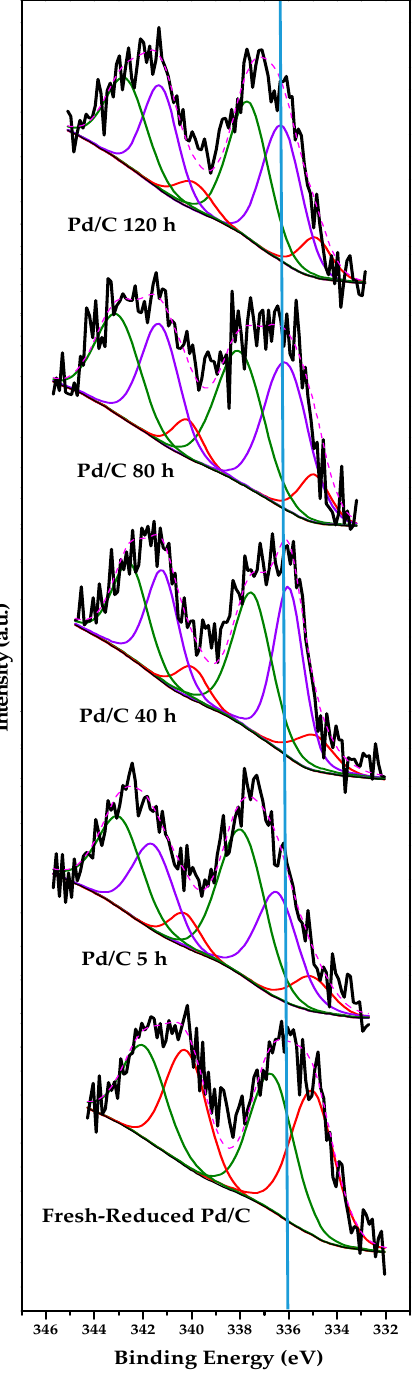
Figure 5. XPS patterns in the Pd 3d region of the Pd / C catalyst after the experiments performed at different times on stream ( τ = 1.73 kg h mol − 1 ) (the overall Pd 3d spectra (black); Pd 0 spectra (red); Pd n+ spectra (green); PdC x spectra (violet); overall fitting line spectra (dash); the blue vertical line indicates the position of the peak of PdC x spectra).